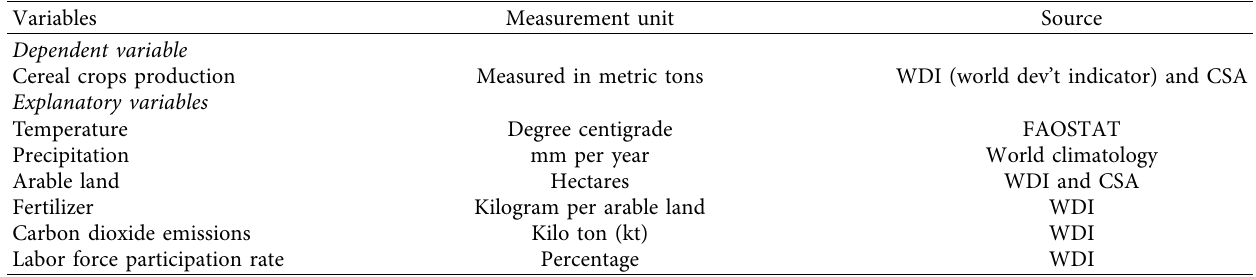
Table 1: Study variables, unit of measurement, and sources of